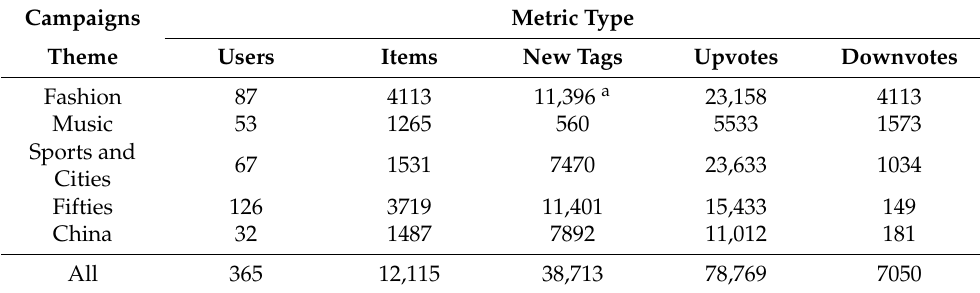
Table 1. Campaign